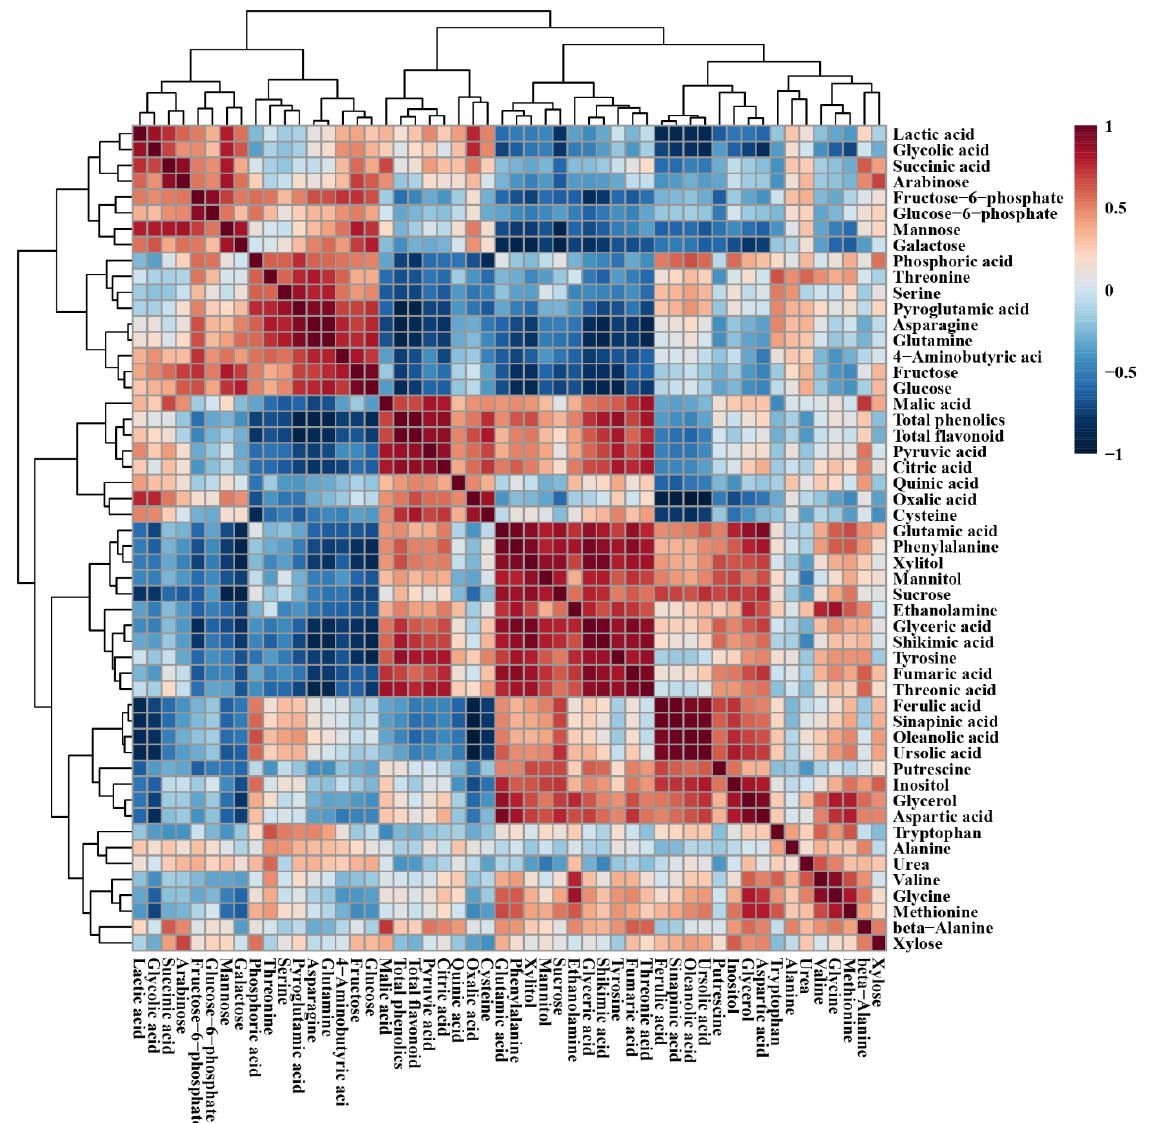
Figure 6. Correlation matrix of metabolites detected in different organs of L . pubescens . Each square indicates the Pearson’s correlation coefficient of a pair of compounds, and the value of the correlation coefficient is represented by the intensity of blue or red colors, as indicated on the color scale.